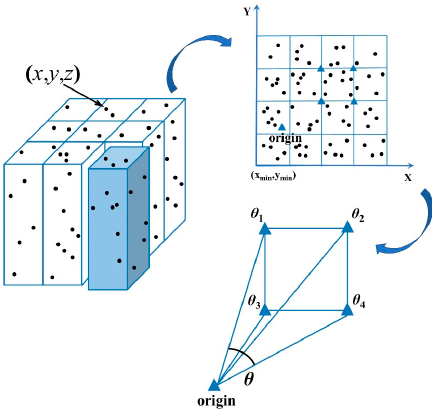
Figure 6. The angle interval of the sub-grid.